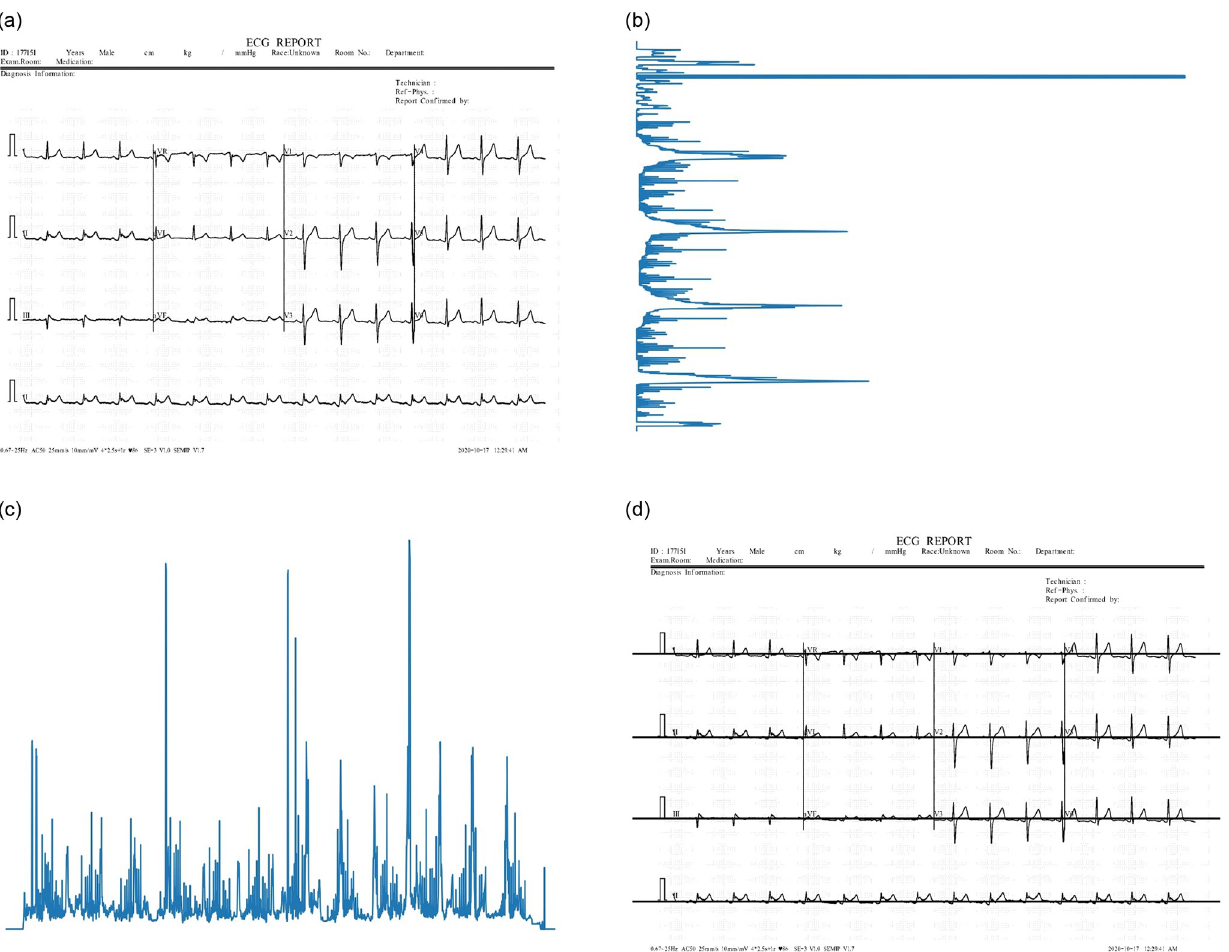
Fig 3. Vertical and horizontal histograms of the ECG image. (b) and (c) are the vertical and horizontal histograms of image (a) , respectively. (b) has peaks corresponding to positions of the horizontal lines at the top of the paper and the isoelectric lines of the ECG signal. (c) has three peaks corresponding to lines separating the leads. In (d) , the black line depicts the positions of all isoelectric